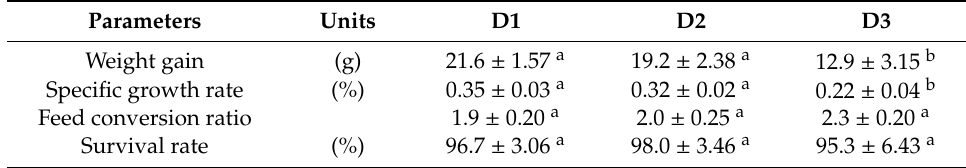
Table 4. Fish growth parameters in the three aquaponic systems during the study period. All values are mean ± standard deviation obtained from three replicates. Di ff erent superscript letters (a, b) within a row indicate statistically di ff erent mean values at p < 0.05; a > b > c (one–way